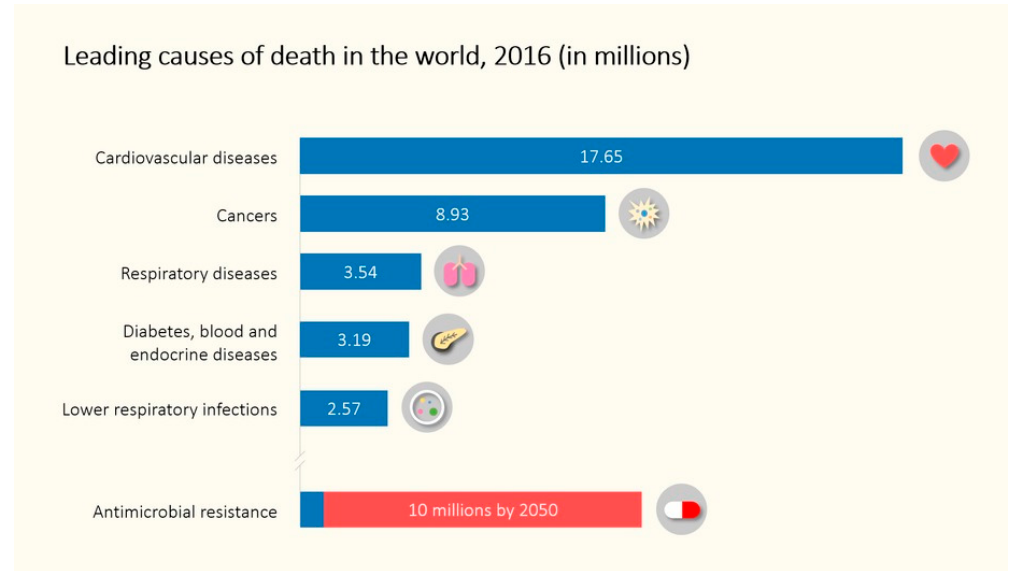
Figure 1. Leading causes of death in the world in 2016 (blue bars) and prognosis for antimicrobial resistance (AMR) related deaths in 2050 (red bar).